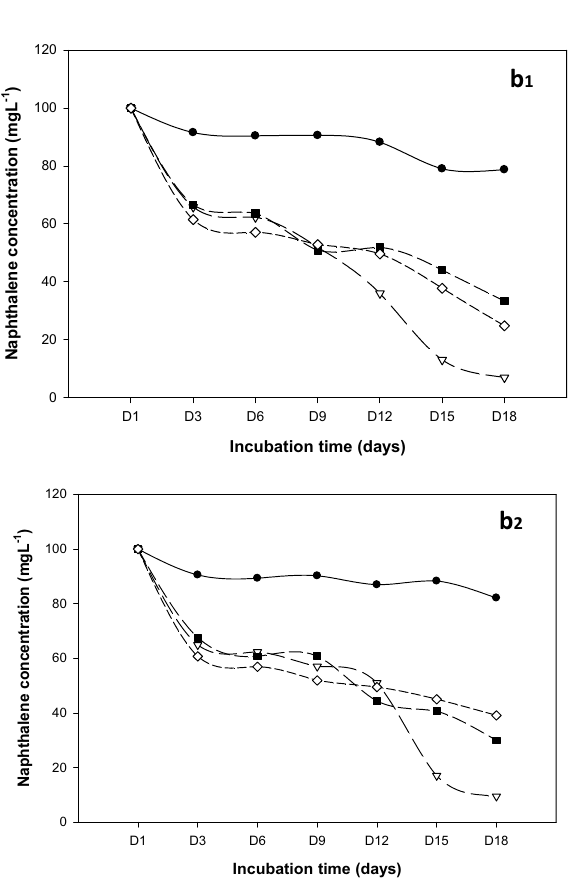
Figure 8. Naphthalene degradation curves at ( b1 ) pH 5.0 and ( b2 ) pH 9.0; Control experiments (solid sphere), B. brevis (solid squares), P. mirabilis (diamond), and R. qinshengi